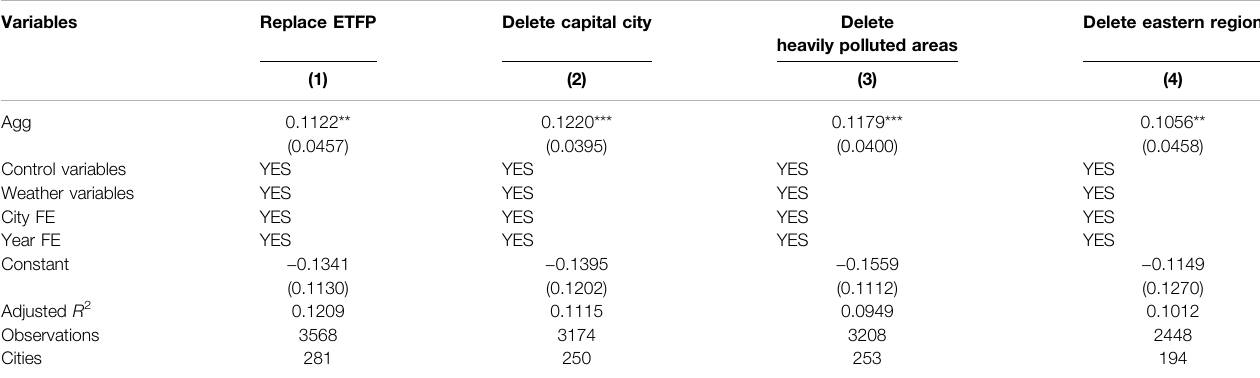
TABLE 4 | Robustness